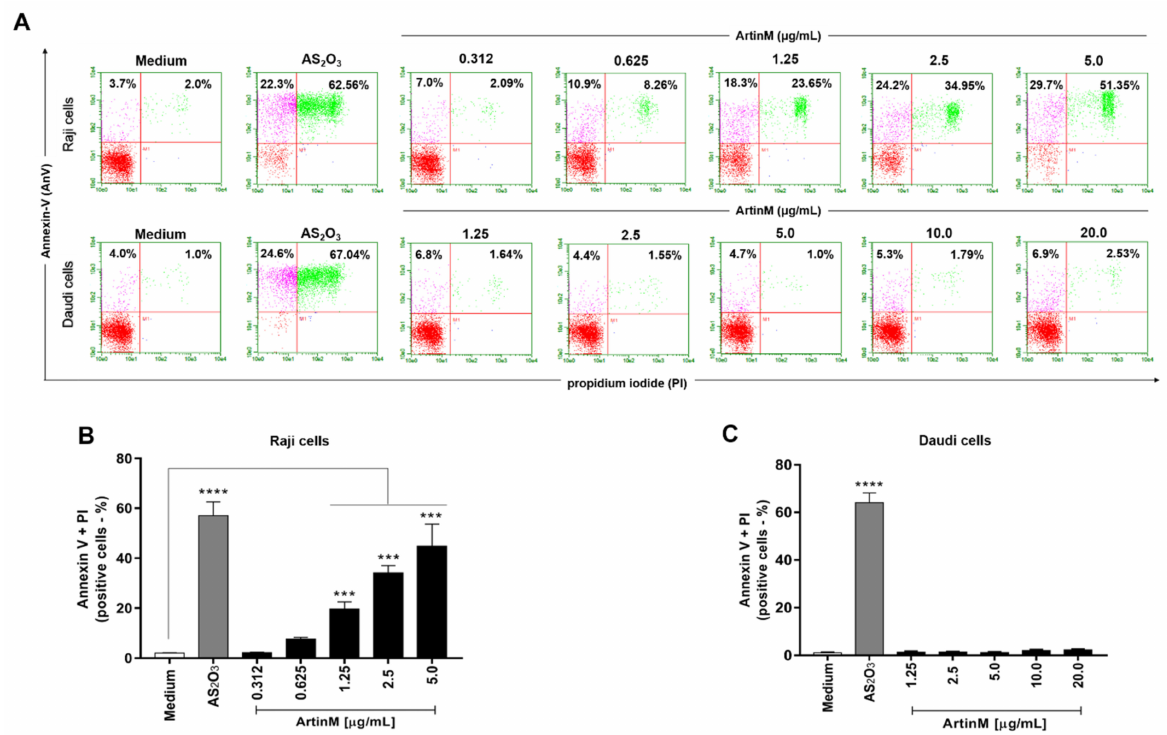
Figure 4. ArtinM induces apoptosis of Raji cells. Raji and Daudi cells (1 × 10 5 cells/mL) were seeded in 96-well microplates and incubated for 48 h at 37 ◦ C with 0.312 to 5.0 µ g/mL and 1.25 to 20.0 µ g/mL ArtinM, respectively. Arsenic trioxide (AS 2 O 3 ) at concentrations of 12 µ M (Raji cells) and 24 µ M (Daudi cells) was used as a positive control for induction of cell death and medium alone was used as a negative control (Medium). The cells were incubated with annexin V-FITC (5.0 µ g/mL) and propidium iodide (10.0 µ g/mL), and the frequency of double-labeled (AnV+/PI+) Raji ( A , B ) and Daudi ( C ) cells was determined by flow cytometry. Values were expressed as mean ± standard error of the mean (SEM). Significant differences compared to the medium are shown by ***, p < 0.001 and ****, p <